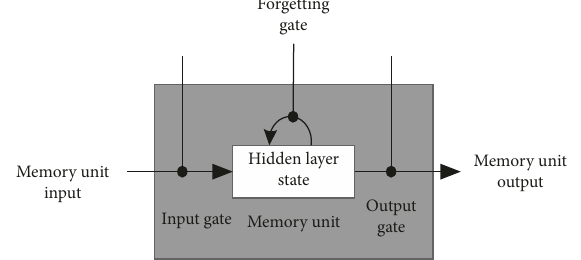
Figure 1: Memory cell structure of long-term and short-term memory